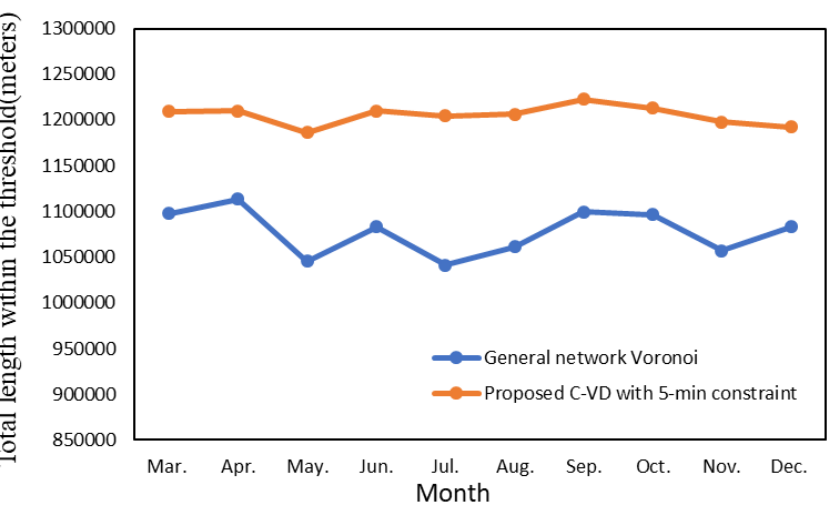
Figure 14. The street segment length of service areas within the Golden 5 min constraint in di ff erent time slices.